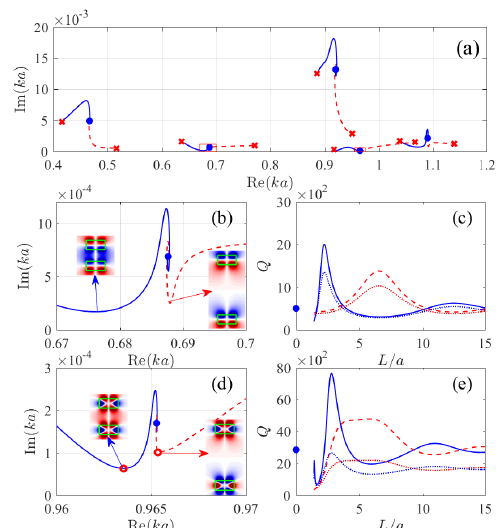
Figure 13: (a) Behavior of resonant eigenfrequencies under variation of the distance between the disks L with ϵ = 40 (ceramics in THz range) and the aspect ratio a/h = 0 . 7 . (b) and (d) zoomed areas highlighted in (a) by red rectangles with symmetric (solid lines) and antisymmetric (dash lines) hybridized resonant modes (20) of. (c) and (e) show be- havior of the Q factor vs the distance. Closed circles mark the eigenfrequencies of isolated disks and respectively the Q factors while crosses mark the limiting case L = a when the two disks stick together. Dotted lines show the behavior of the Q factors with account of material losses in ceramic disks with tan δ = 2 . 5 × 10 − 4 in THz range